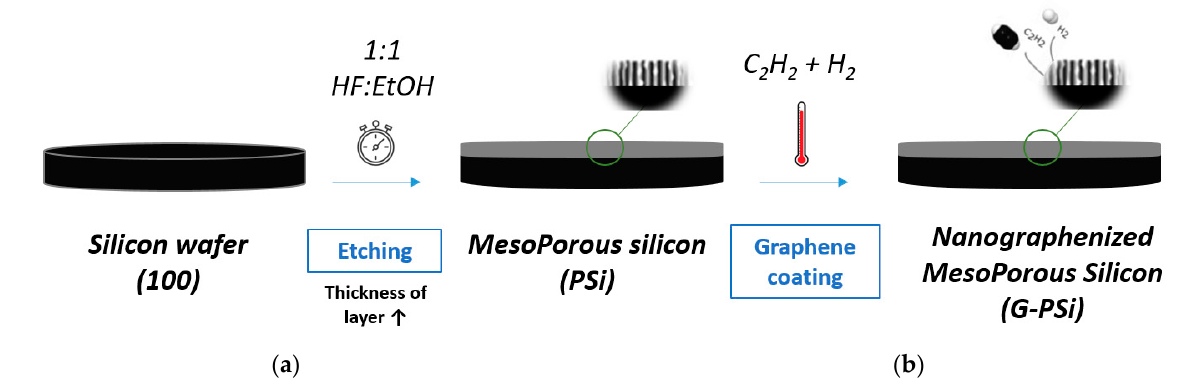
Figure 1. ( a ) Electrochemical etching step and ( b ) graphene coating by CVD. Table 1. Electrochemical etching process characteristics.